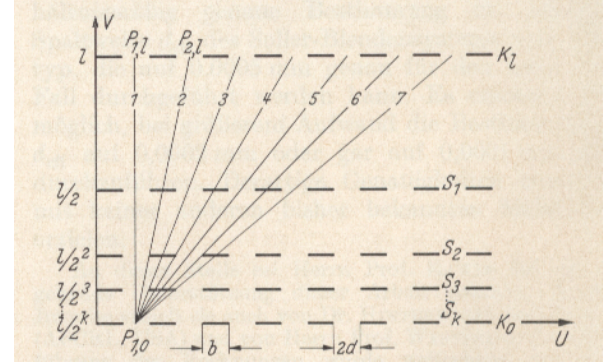
Figure 31. Geometrical arrangement of grids to block perturb- ing cross rays (Schmidtke, 1968; copyright permission granted by Springer).